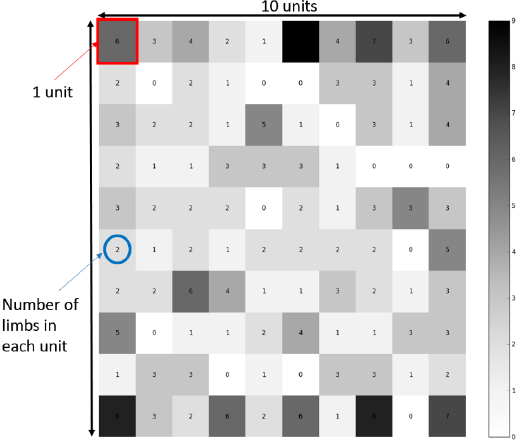
Figure 1. The self-organizing map (SOM) grouped together participants with similar inputs. The map was a 10 × 10 square units; each limb was localized in one of the 100 square units. A square unit could have multiple limbs (the number in each unit is displayed in the square unit). Limbs grouped together in the same unit on the map had similar inputs. This figure represents the distribution of each participant limb in the map, with white being no limbs in the unit and black being nine participants’ limbs associated to the unit.